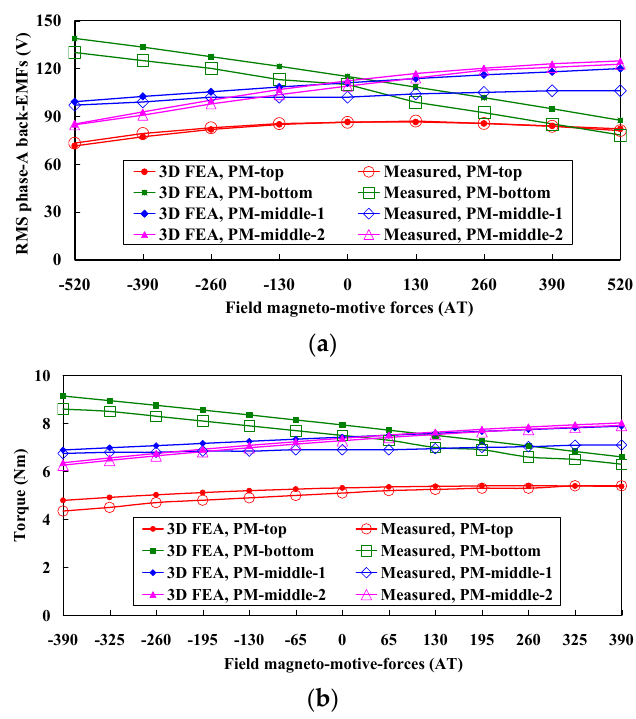
Figure 22. Comparisons of the regulation results by different field currents. ( a ) No-load RMS phase-A EMF values at 1500 r/min; ( b ) Average torque values when RMS 285 AT is applied in half armature slot.